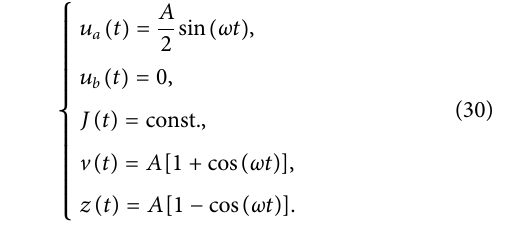
concentrates on the N th cavity mode (RC edge state) at the end of the fi rst pumping cycle, and then the excitation expands into the bulk again and concentrates on the fi rst mechanical mode (LM edge state) at the end of the second pumping cycle. These results are consistent with the instantaneous spectrum in the adiabatic limit, as shown in Figure 8 . However, due to the Landau Zener transition, which occurs at the degenerate points ω t (cid:1) 2 n π ( n is